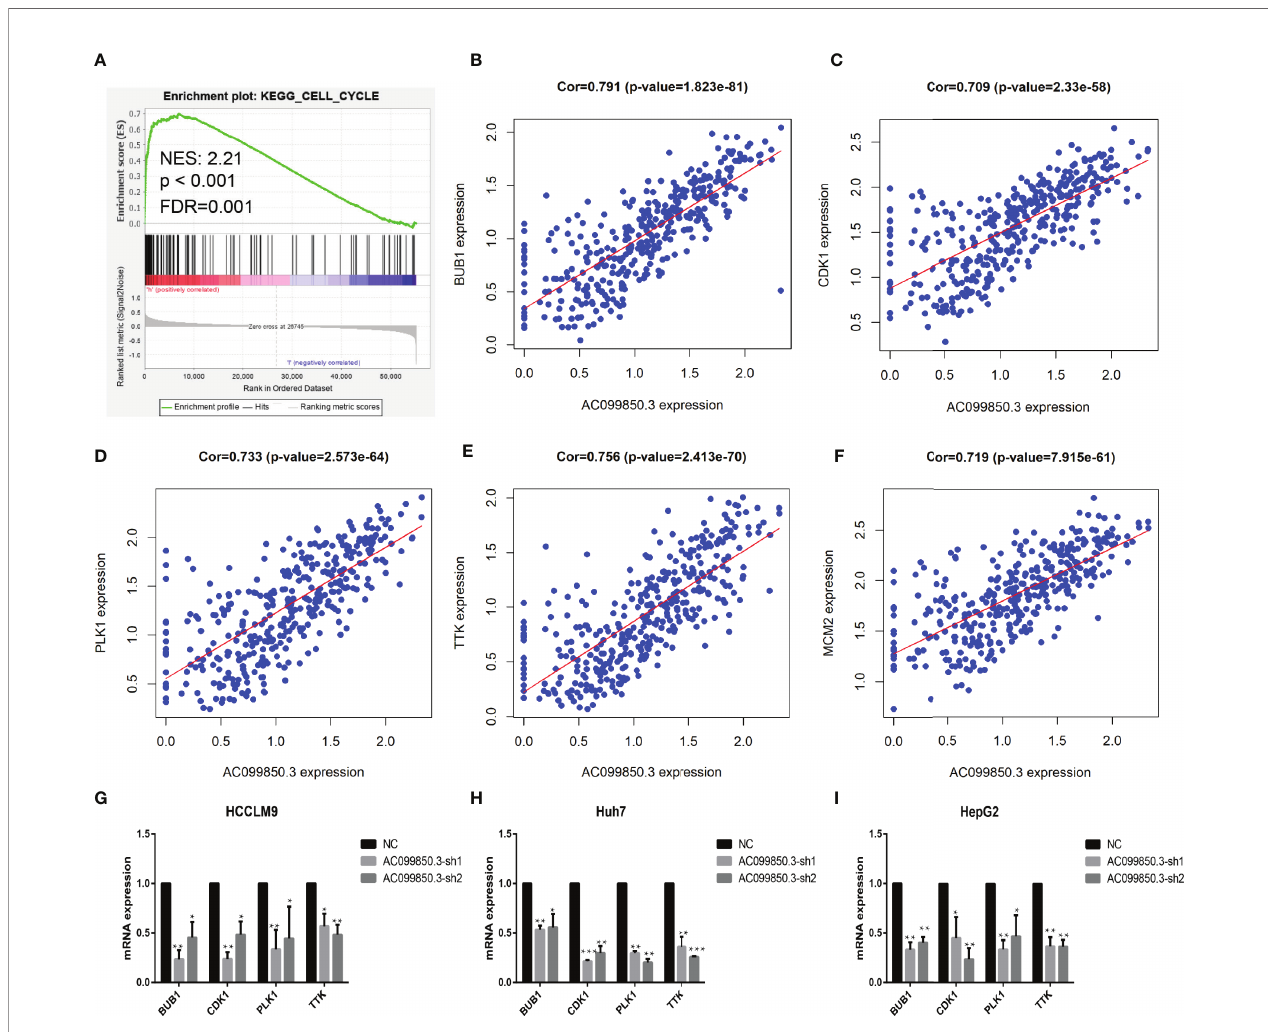
FIGURE 10 | The relevant mechanism of AC099850.3. (A) GSEA showed that AC099850.3 was related to the cell cycle signalling pathway. The horizontal axis was each gene under the gene, and the vertical axis was the corresponding Running ES (enrichment score). There was a peak in the line chart, and the peak was the ES of the gene set. NES represented the normalized Enrichment score, and FDR q-val represented the p value corrected by multiple hypothesis tests. (B – F) Coexpression analysis predicted the AC099850.3-related cell cycle molecules BUB1, CDK1, PLK1, TTK, and MCM2 (cor > 0.7). (G – I) The results of the PCR assay showed that the interference groups had inhibited expression of the cell cycle molecules BUB1, CDK1, PLK1, and TTK. (*P < 0.05, **P < 0.01, ***P